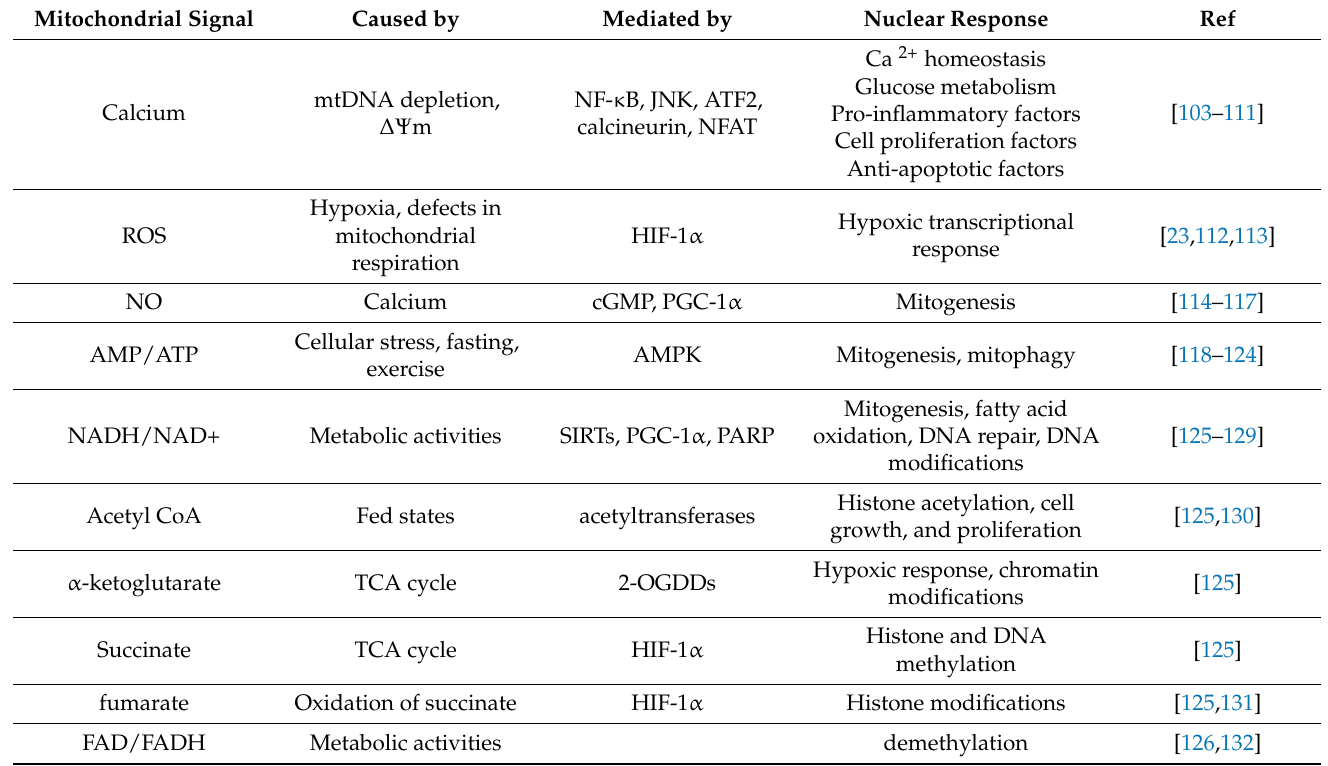
Table 2. Mitochondrial signals that trigger a nuclear